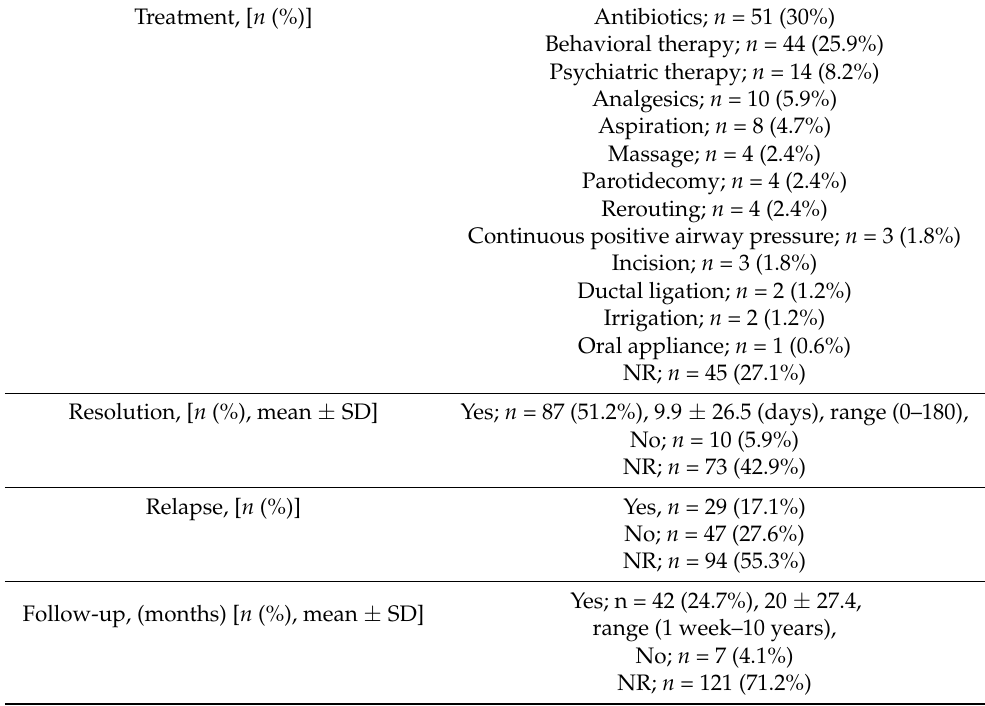
Table 3. Treatment outcomes and sequelae. NR; not reported, SD; standard